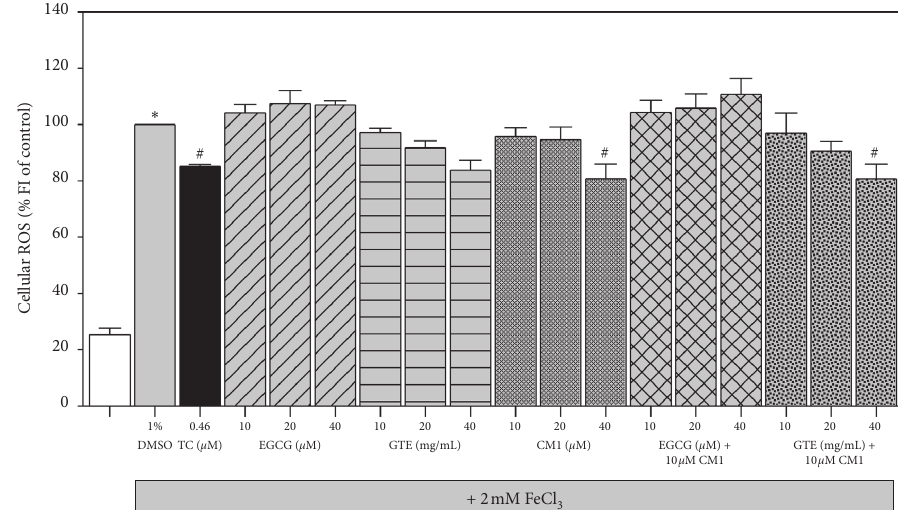
Figure 4: Levels of ROS in SH-SY5Y cells after being exposed to treatments with or without 2mM FeCl DMSO, TC (0.46 μ M), CM1 (10–40 μ M), EGCG (10–40 μ M), GTE (10, 20, and 40 mg/mL equivalent to 5.24, 10.48, and 20.96 μ M EGCG, respectively), and combinations for 24h. Data obtained from three independent duplicate experiments are expressed as mean ± SEM values. ∗ P < 0 . 05 when compared to the untreated cells without iron loading; # P < 0 . 05 when compared to the iron-loaded cells treated with 1% DMSO.